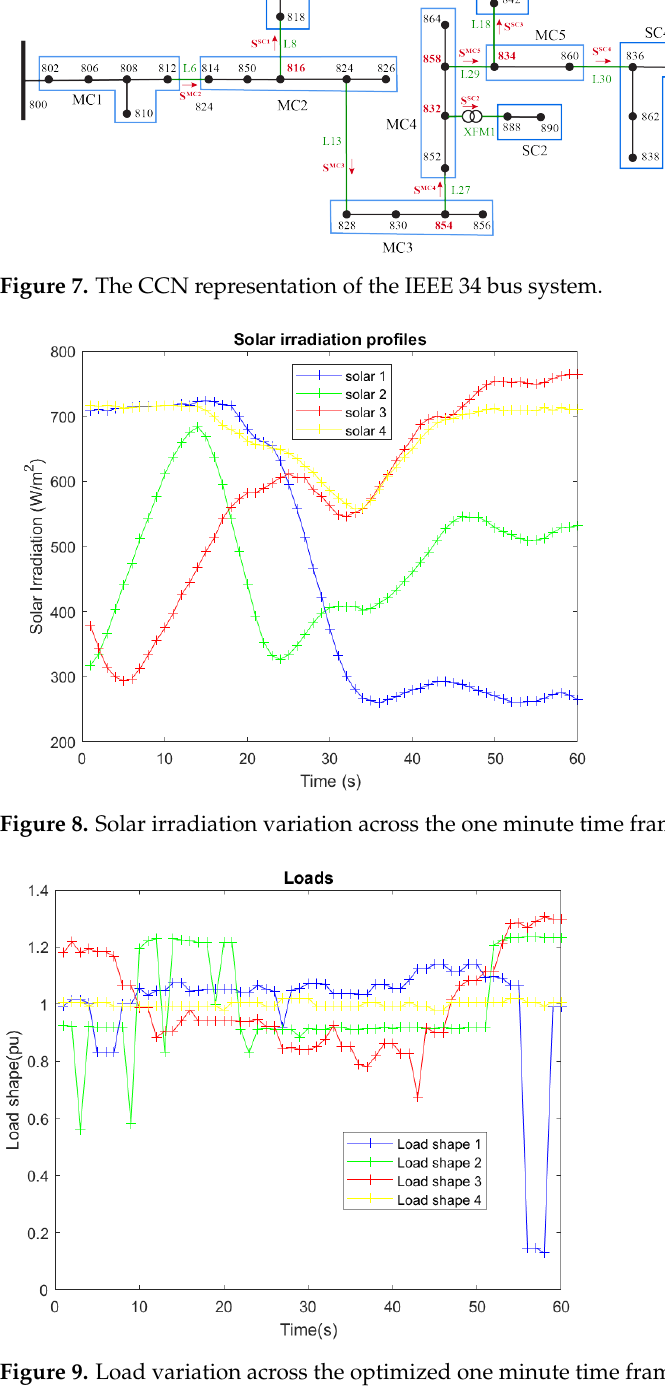
Figure 9. Load variation across the optimized one minute time